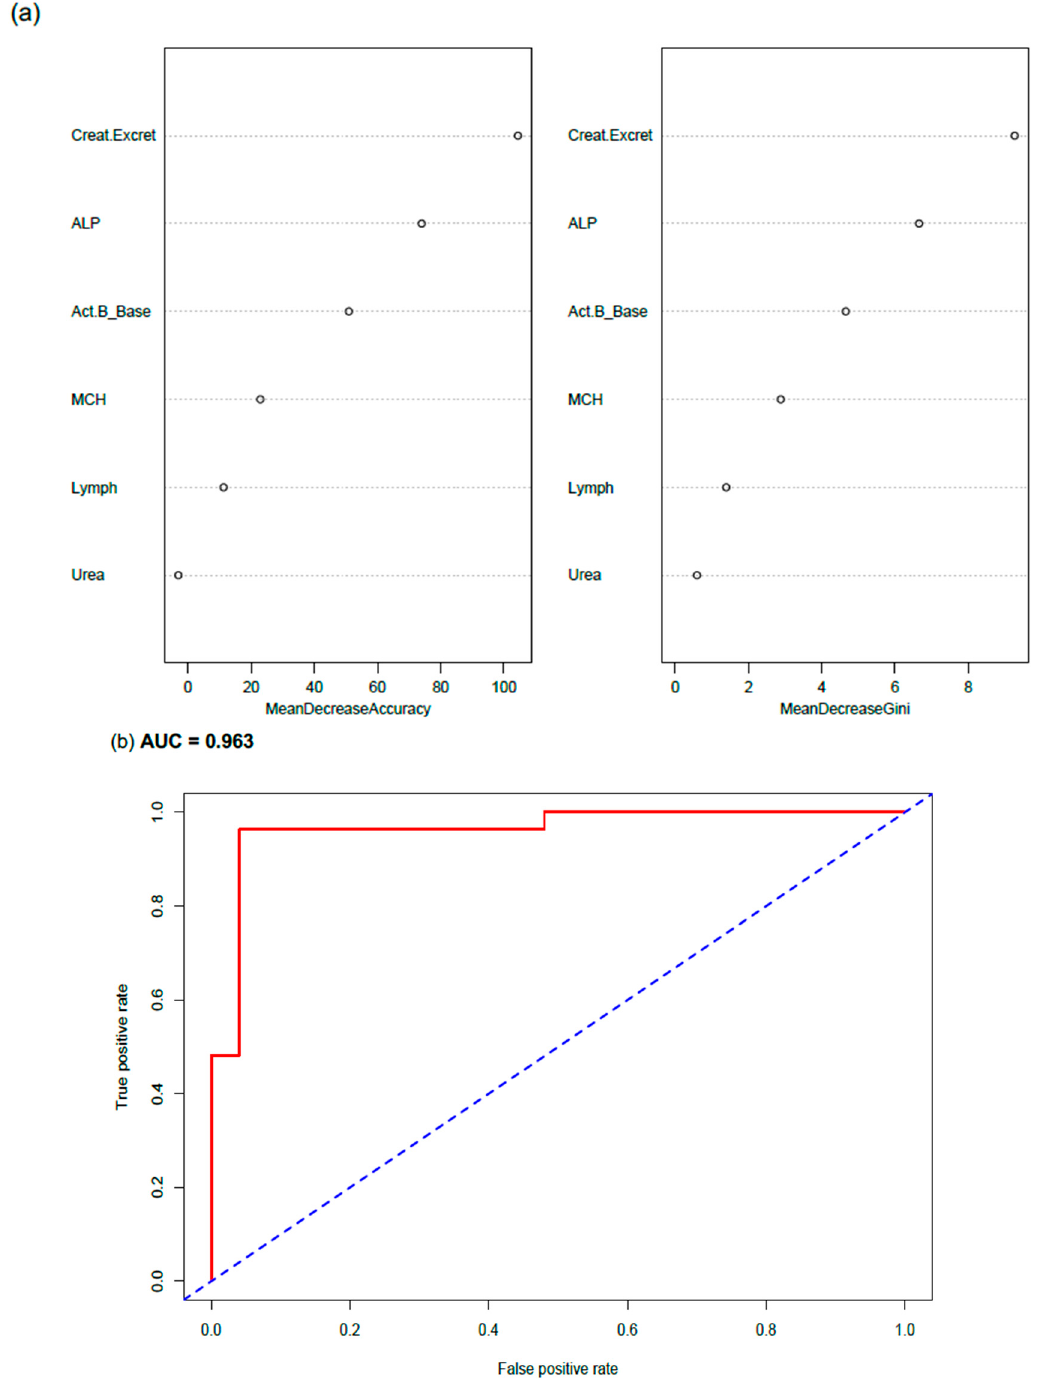
Figure 4. ( a ) Random Forest Analysis (RFA) and ( b ) Receiver Operating Characteristic (ROC) investigations on the prediction of Weighted Standing Time (WST) using only correctly predicted cases from the WST classes 0 versus 1, and the relative importance of activin B and pathology markers in separating the two WST classes of ME/CFS severity. Correct case prediction was performed via RF. AUC—area under curve (accuracy calculation from true and false positive rates).